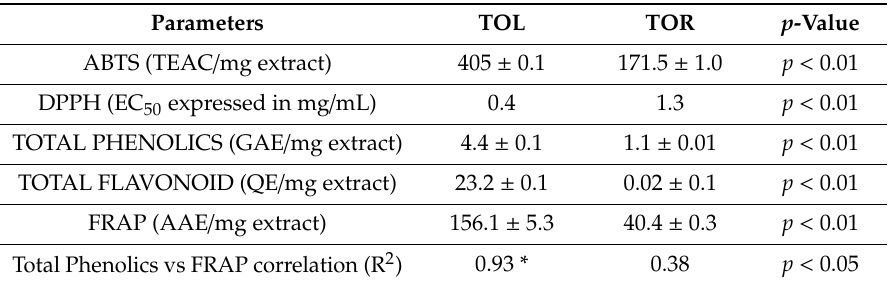
Table 1. In vitro antioxidant